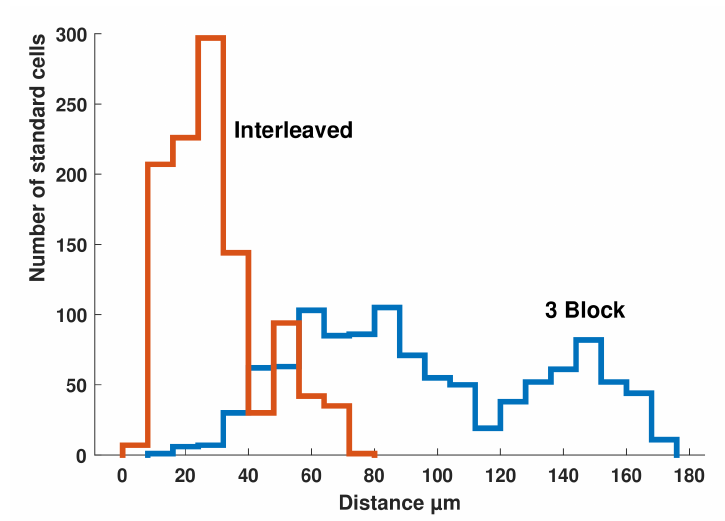
Figure 5. TMR branch logic spacing for the 8 × 16 bit design.